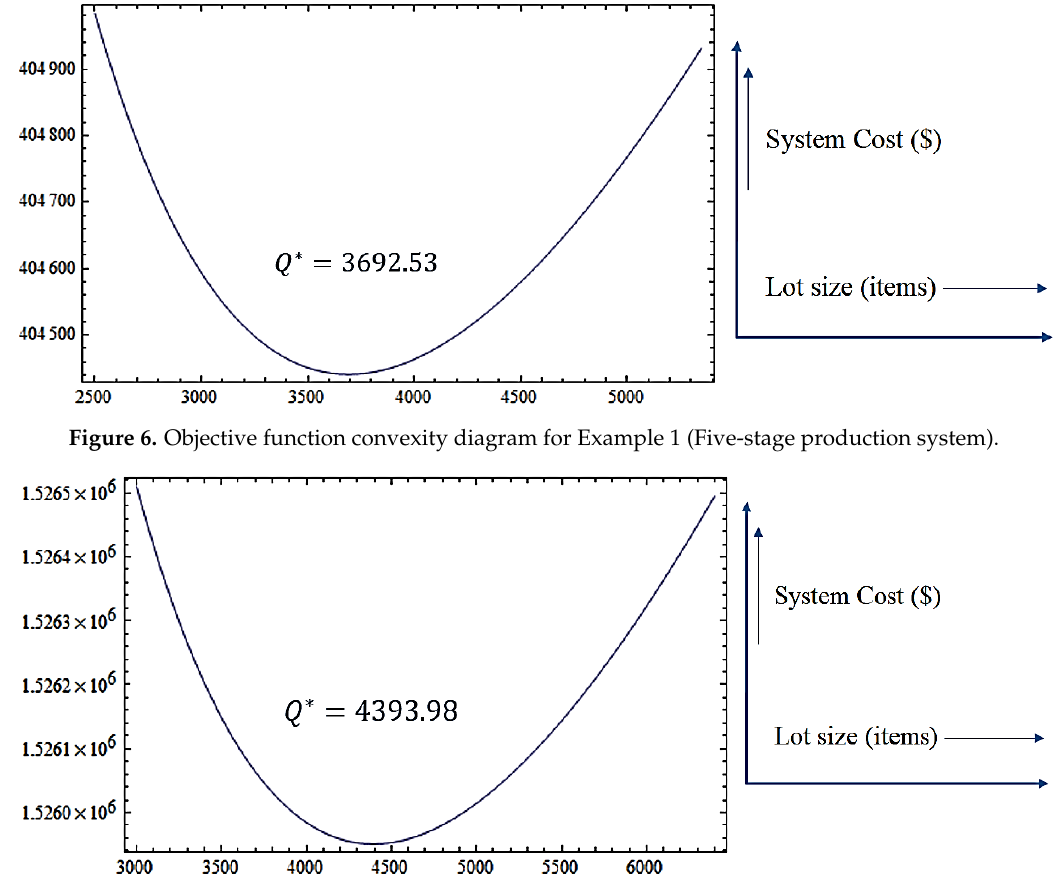
Figure 7. Objective function convexity diagram for Example 2 (Five-stage production system).